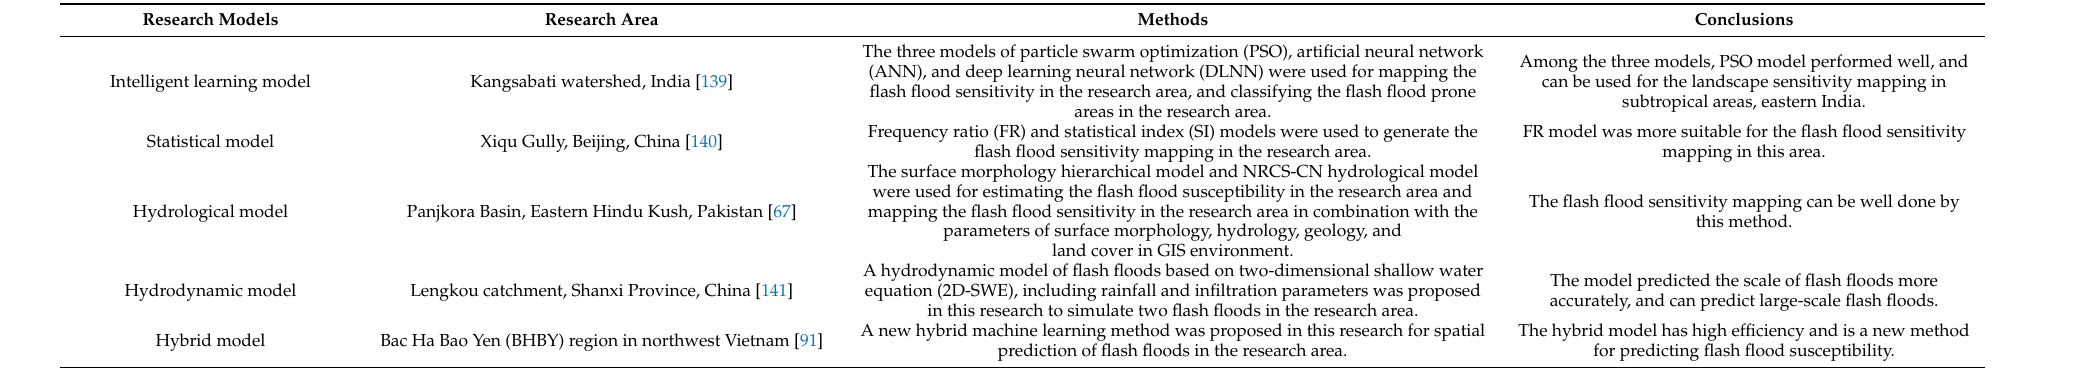
Table 10. Representative assessment